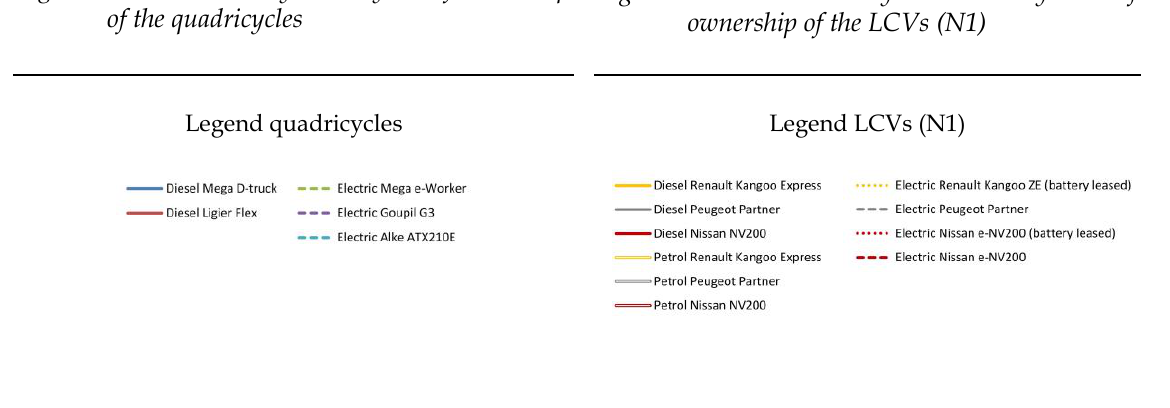
Figure 6. TCO sensitivity on the years